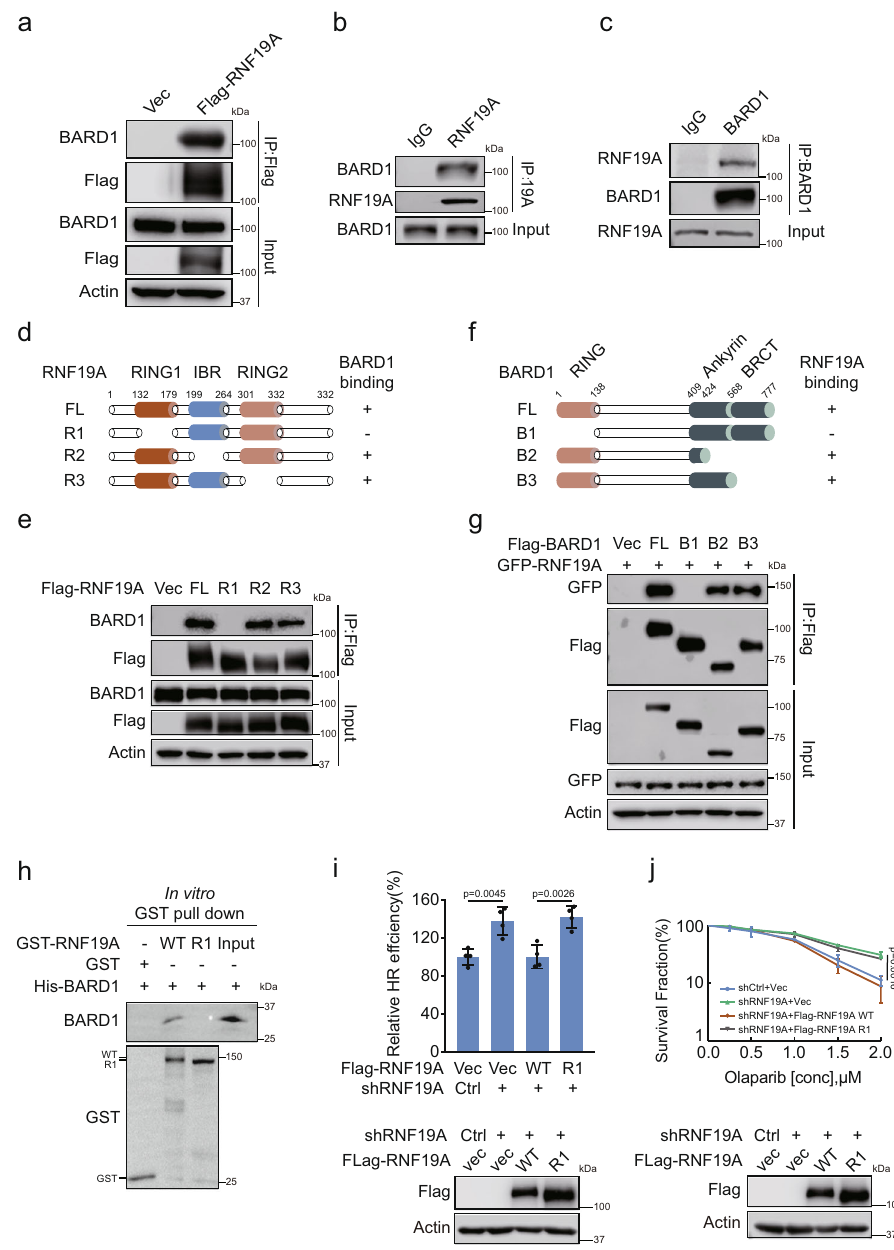
Fig. 2 RNF19A interacts with the BARD1 RING domain through its RING2 region. a HEK293T cells were transfected with Vec or Flag-RNF19A. Cell lysates were subjected to immunoprecipitation with Flag beads and immunoblotted with the indicated antibodies. b – c HEK293T cell lysates were subjected to immunoprecipitation with control IgG, RNF19A ( b ), or BARD1 ( c ) antibodies and immunoblotted with the indicated antibodies. d – e Diagram of RNF19A- WT and mutation constructs ( d ). R1, deletion of the RING1 domain (aa132 – 179); R2, deletion of the IBR domain (aa199 – 264); and R3, deletion of the RING2 domain (aa301 – 332). HEK293T cells transfected with Vec, WT, or deletion mutants of Flag-RNF19A outlined in ( d ) were subjected to immunoprecipitation as in a . f – g Diagram of BARD1-WT and mutation constructs ( f ). B1, deletion of the RING domain (aa1 – 138); B2, deletion of BRCT and parts of Ankyrin domain (aa424 – 777); and B3, deletion of the BRCT domain (aa568 – 777). HEK293T cells transfected with Vec, WT, or deletion mutants of Flag-BARD1 outlined in f together with GFP-RN19A were subjected to immunoprecipitation with Flag beads and immunoblotted with the indicated antibodies. h Interaction between RNF19A and BARD1 was analyzed by in vitro GST pull-down assays using puri fi ed GST-RNF19A and His-BARD1 proteins. i Control (Ctrl) and RNF19A knockdown HEK293T cells stably expressing Vec, WT, or R1 Flag-RNF19A were subjected to DR-GFP-based HR assay. j Control (Ctrl) and RNF19A knockdown U2OS cells stably expressing Vec, WT, or R1 Flag-RNF19A were subjected to colony formation assay for assessment of the sensitivity to Olaparib. Error bars represent means ± s.d. of four ( i ) or three ( j ) independent experiments. p values are determined by unpaired two-sided t test in i and j . Source data are provided as a Source Data fi